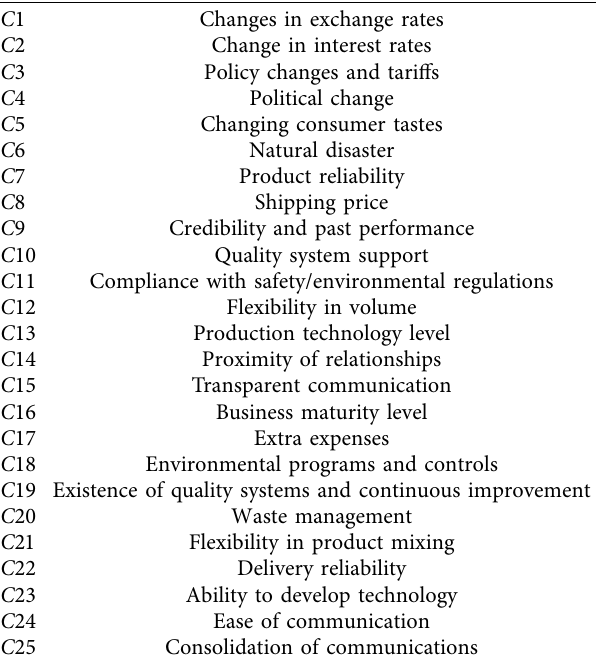
Table 4: Indicators in the supply chain and supplier